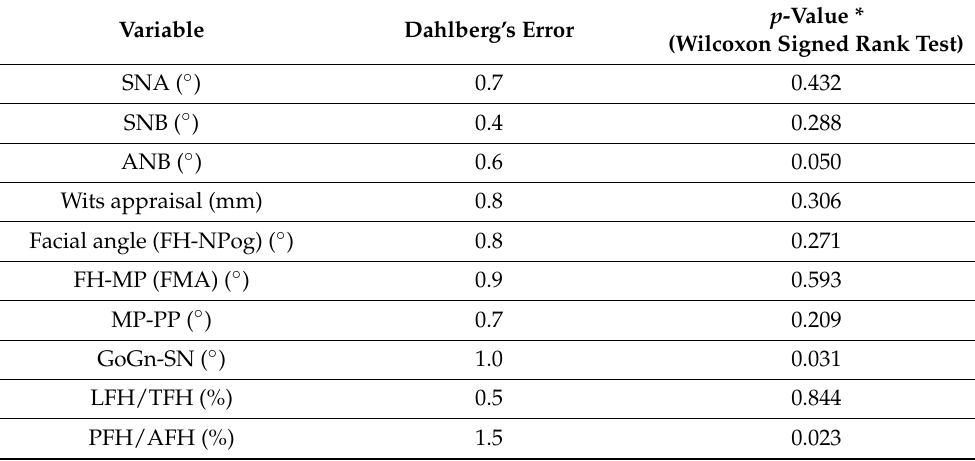
Table A1. Dahlberg error rates for selected measurements (intraoperator